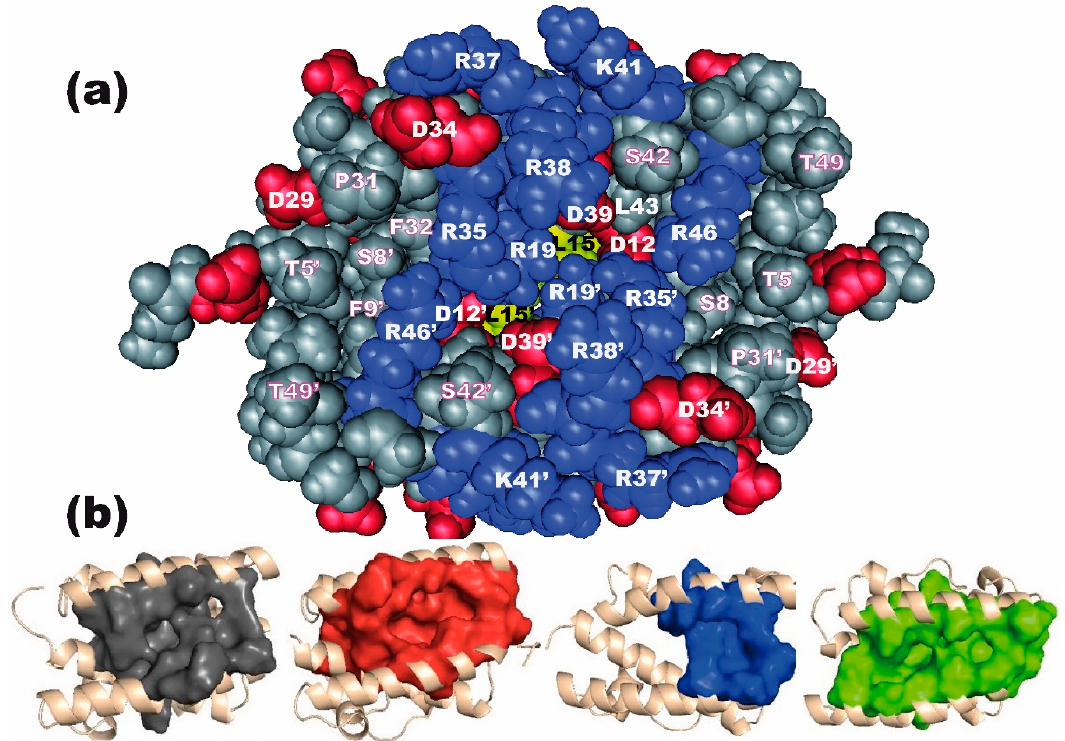
Figure 7. Top view of the groove. ( a ) Space-filling representation of the RBD using software Cn3D. Viewed from above the two nearly coplanar α -helices 2 and 2 ′ , the structure is that of the 1918-Brevig Mission virus (PDB access N ◦ 2N74), which, unlike 4OPA, has the wild-type residues at positions 38 and 41. Charged residues (red: acidic residues Asp, Glu; blue: basic residues Arg, Lys, His) are highlighted, as well as the two L15 residues at the bottom of the groove (yellow). Most of the indicated residues belong to α -helices 2 and 2 (cid:48) (residues P31-T49). ( b ) Surface rendering representative of the four groups of pockets (in the order A, B, C,